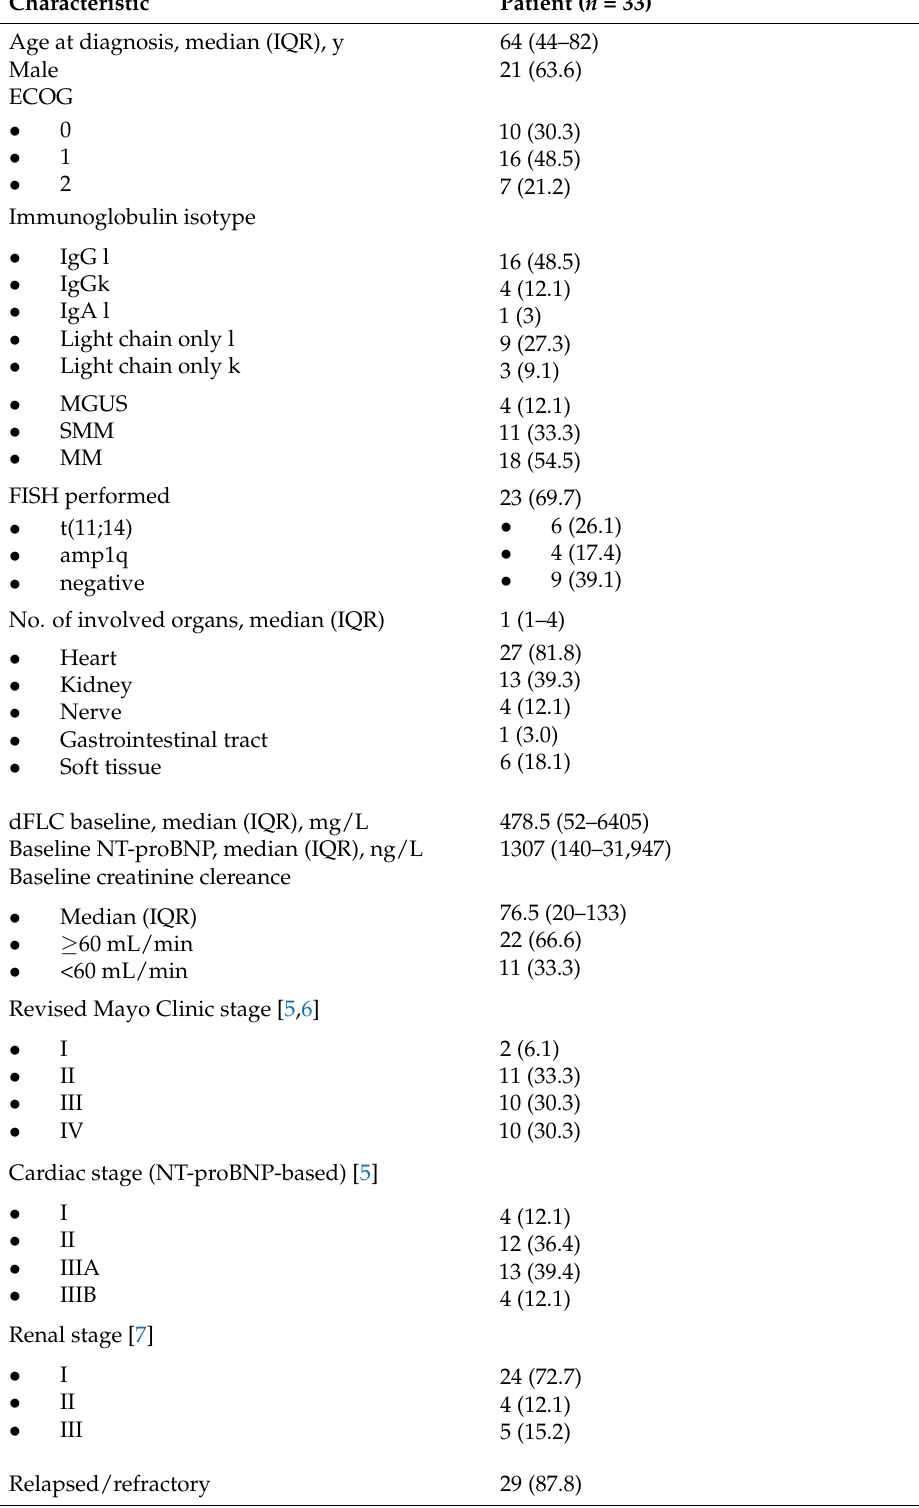
Table 1. Patients’